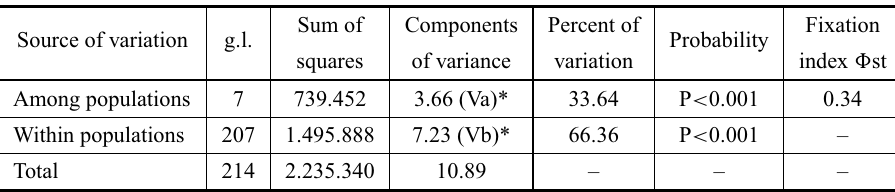
Analysis of molecular variance (AMOVA) for eight geographical populations of Chlosyne lacinia